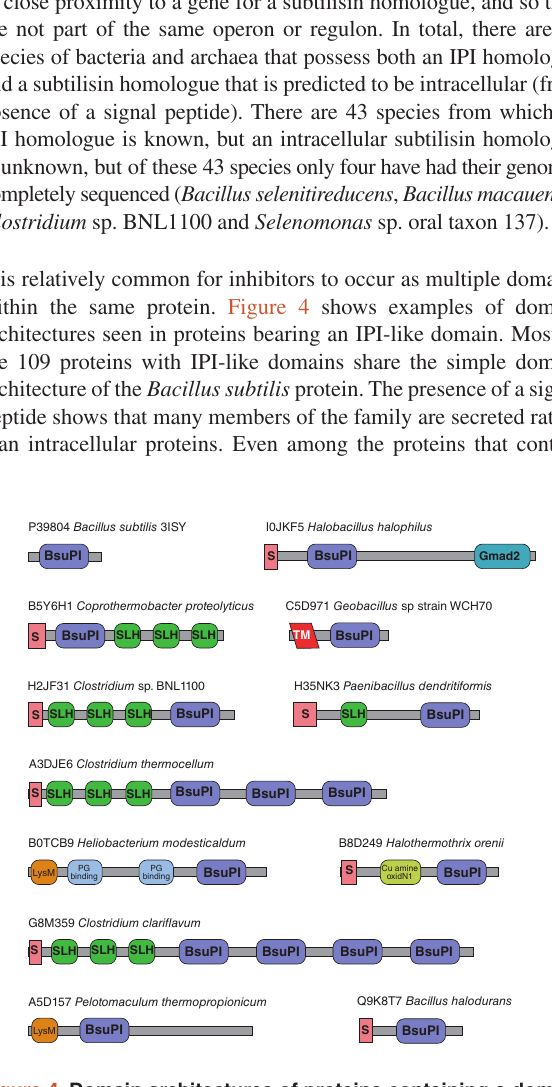
Figure 4. Domain architectures of proteins containing a domain homologous to Intracellular Protease Inhibitor (IPI). Key to domains: BsuPI, Bacillus subtilis protein inhibitor-like; S, signal peptide; Gmad2, immunoglobulin-like domain of bacterial